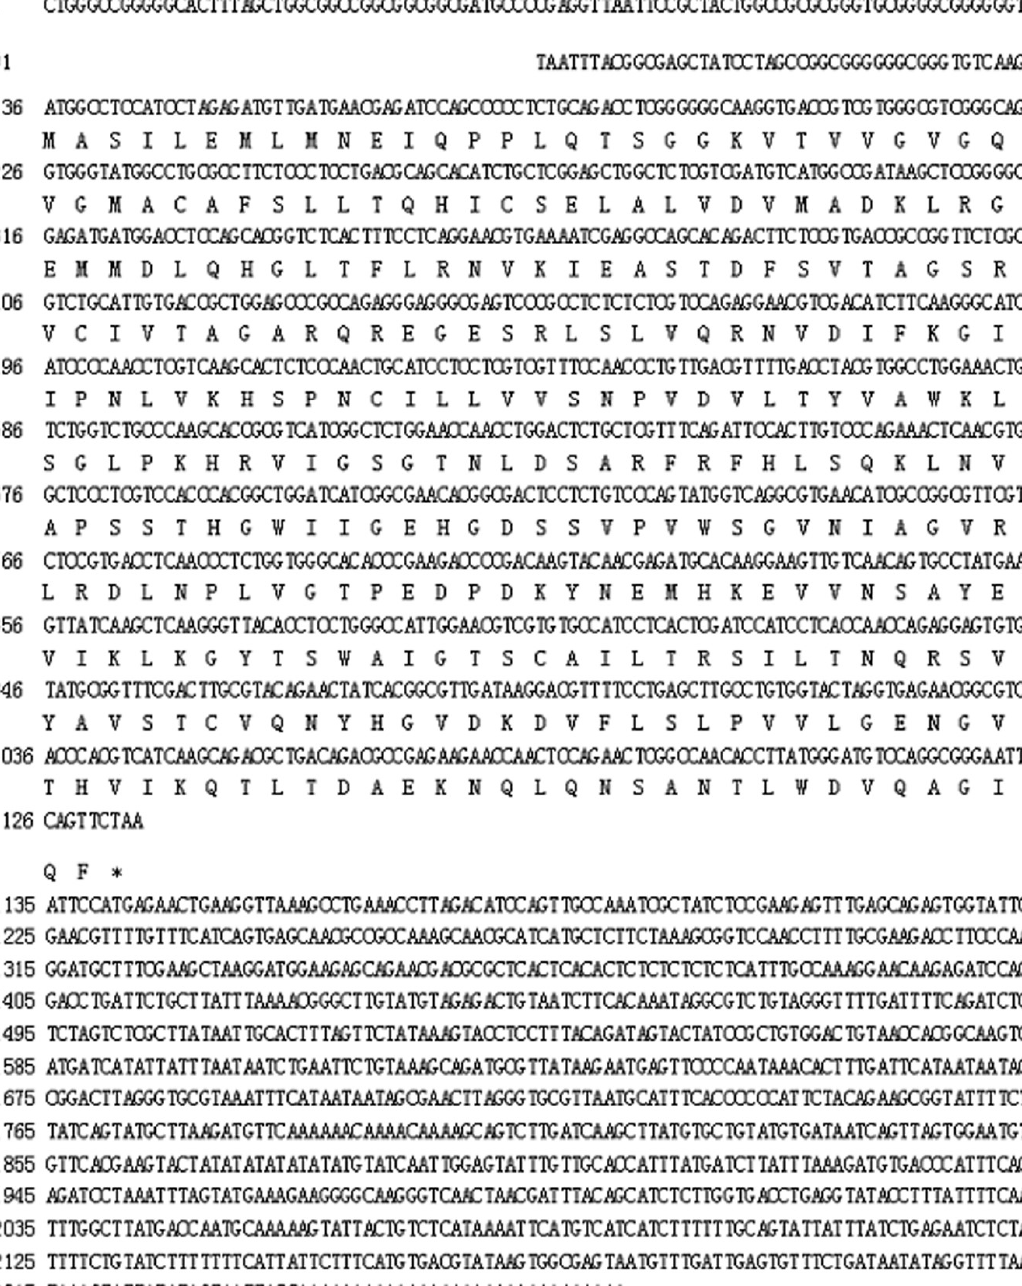
Figure 1. Nucleotide and predicted protein sequences of Macrobrachium nipponense LDH. The asterisk indicates a stop codon.